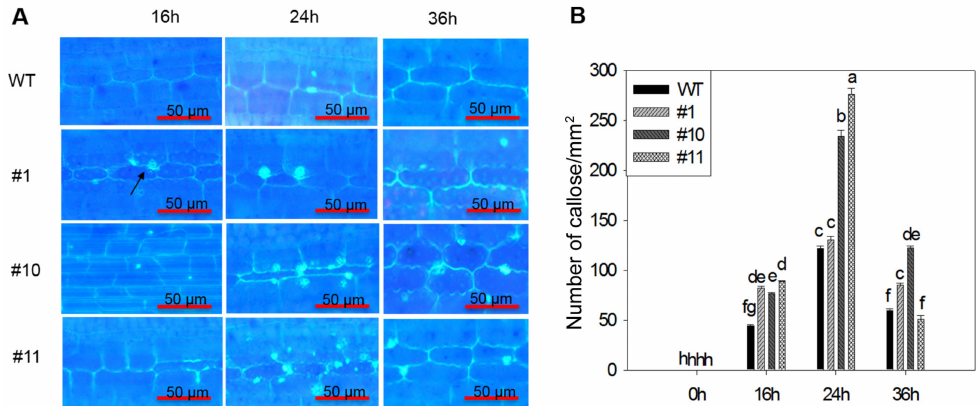
Figure 3. Callose deposition in sheath cells. ( A ) The pictures showing deposited callose in sheath cells. The bright spots marked with black arrows were deposited callose. ( B ) The number of callose deposition in sheath cells of WT and MoSDT1 transgenic lines. Di ff erent letters represent statistically significant di ff erences ( p < 0.05). Bars = 50 µ m.